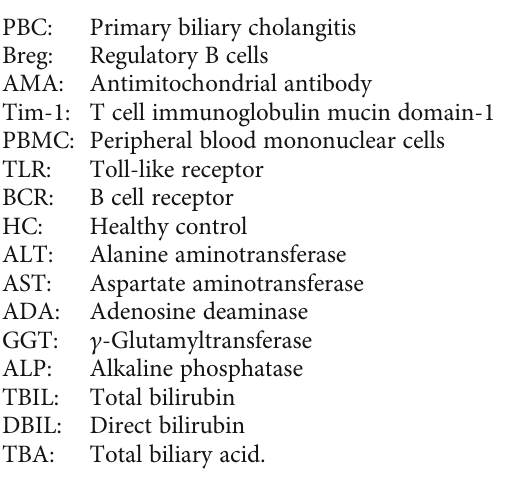
Figure 3: further supplement result 3.7 in our manuscript, which is a completed cross-linked coculture experiment between CD4 + T cells from HC or PBC, with CD19 +- CD24 high CD38 high B cells from HC or PBC (manuscript line 235-239). (Supplementary